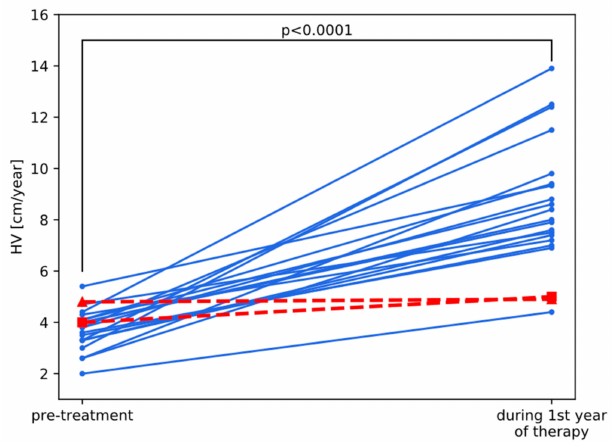
Figure 3. Comparison of pretreatment and final height in AGA-IGFD children. Red lines with triangle and square markers indicate nonresponders 1 and 2, respectively (Table 3). P -value from Wilcoxon test.